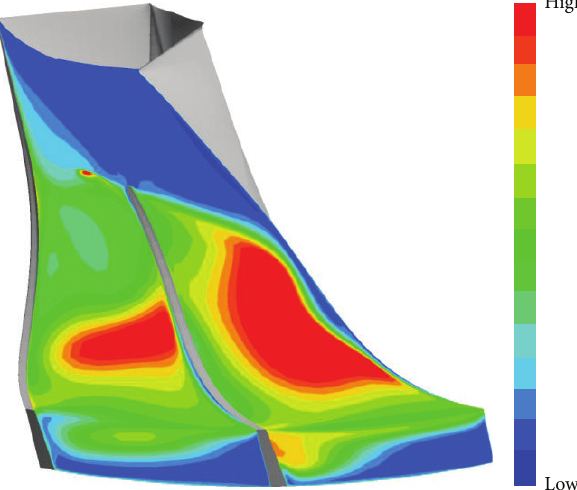
Figure 13: 𝑏/𝑏 2 = 1.00 .